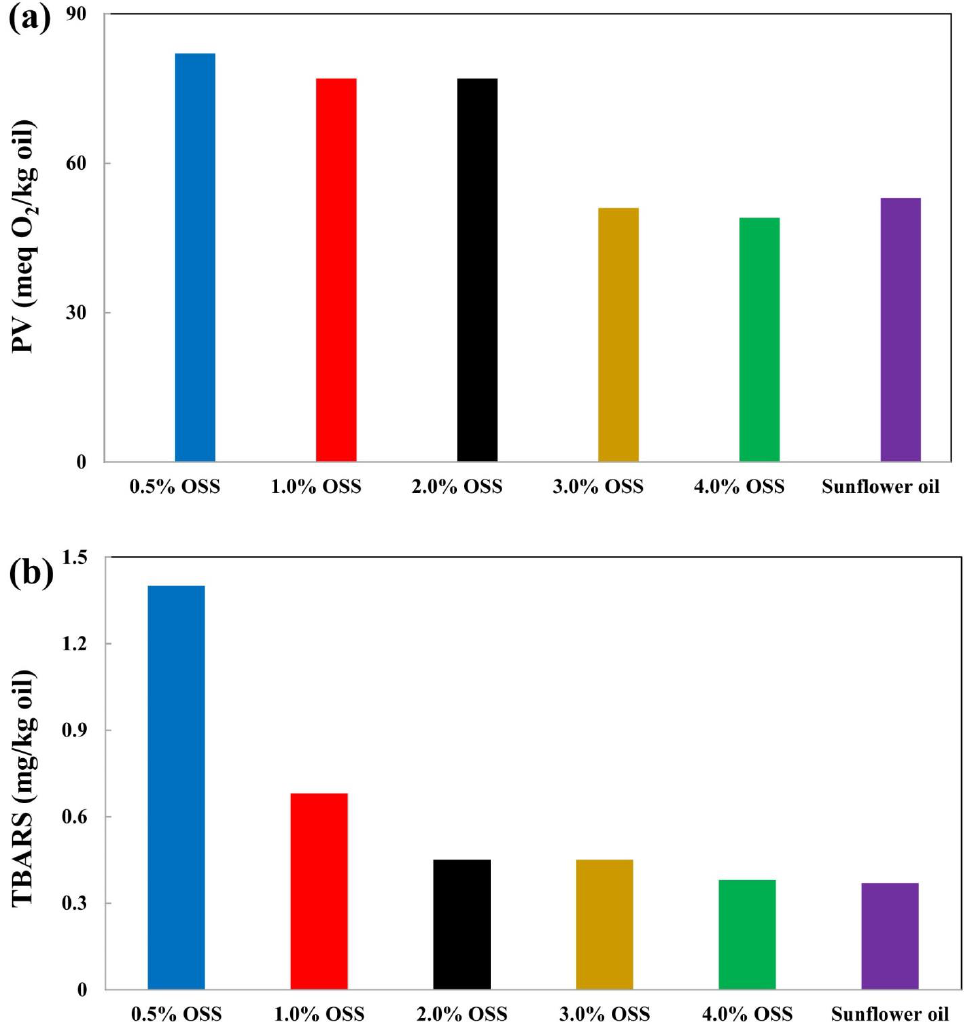
Figure 2. ( a ) Peroxide value (PV); ( b ) thiobarbituric acid reactive substances value (TBARS) of Picker- ing emulsions with different octenyl succinic anhydride modified starch particle (OSS) concentration after 14 days of storage at 50 °C (adopted from Ref. [5]).